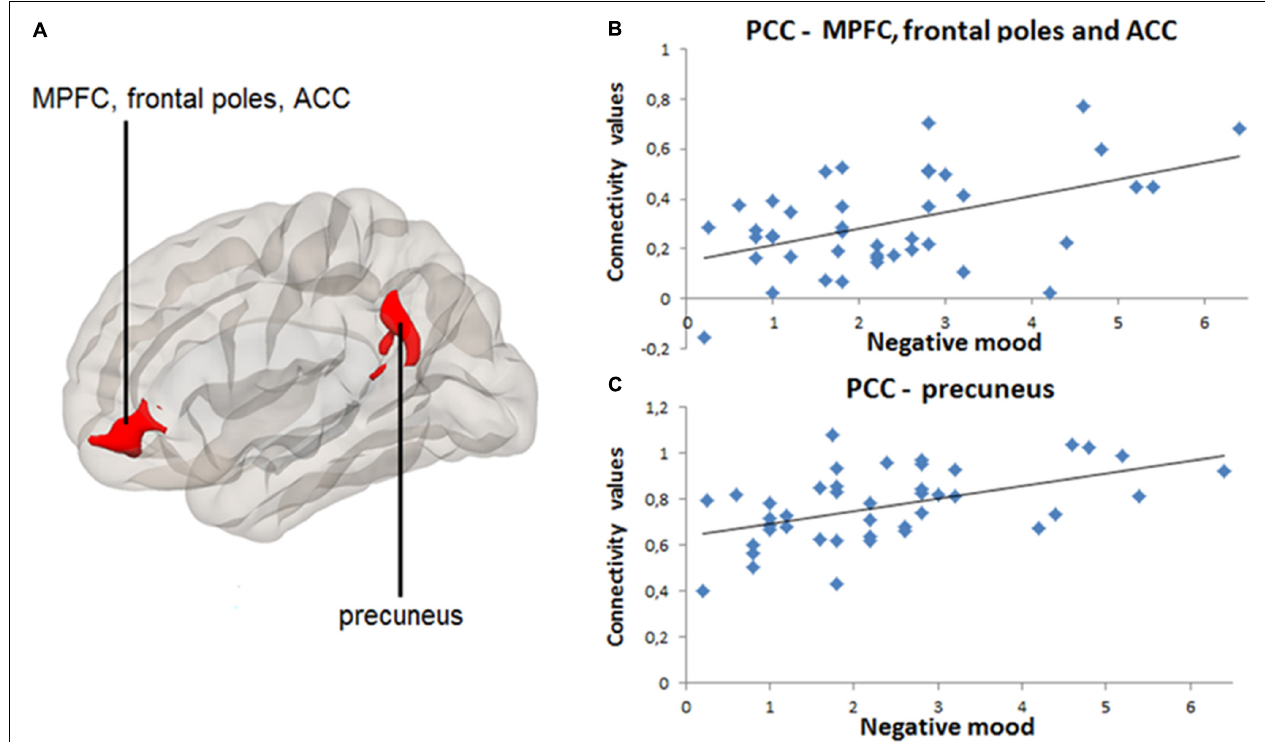
FIGURE 2 | Positive correlation between daily negative mood and resting-state connectivity between posterior cingulate cortex (PCC) and medial prefrontal cortex (MPFC), frontal poles, anterior cingulate cortex (ACC), as well as between PCC and precuneus. PCC-based seed-to-voxel connectivity 3D map presented using CONN toolbox. (A) Left red cluster depicts MPFC, frontal poles, and ACC positively coupled with PCC. Right red cluster depicts precuneus positively coupled with PCC. (B) Scatter-plot for visual inspection illustrates the result from the extracted mean connectivity values of the left cluster within the default-mode network (DMN). Data was taken at peak Montreal Neurological Institute (MNI) coordinates: –4, 40, –6; k = 609; cluster p FWE < 0.001. (C) Scatter-plot for visual inspection illustrates the result from the extracted mean connectivity values of the right cluster within the DMN. Data was taken at MNI coordinates: –6, –54, 34; k = 939; cluster p FWE <